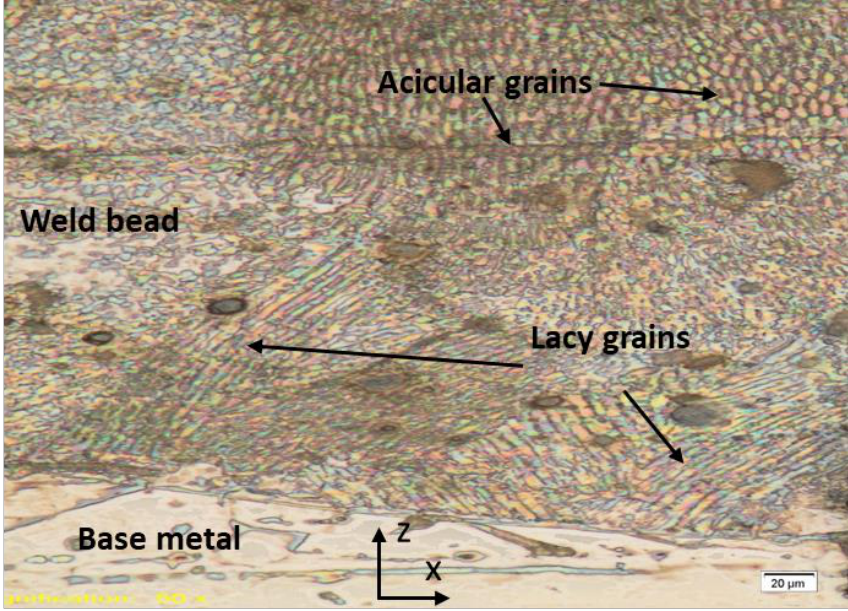
Figure 10. The microstructural view of the welding region in the serum